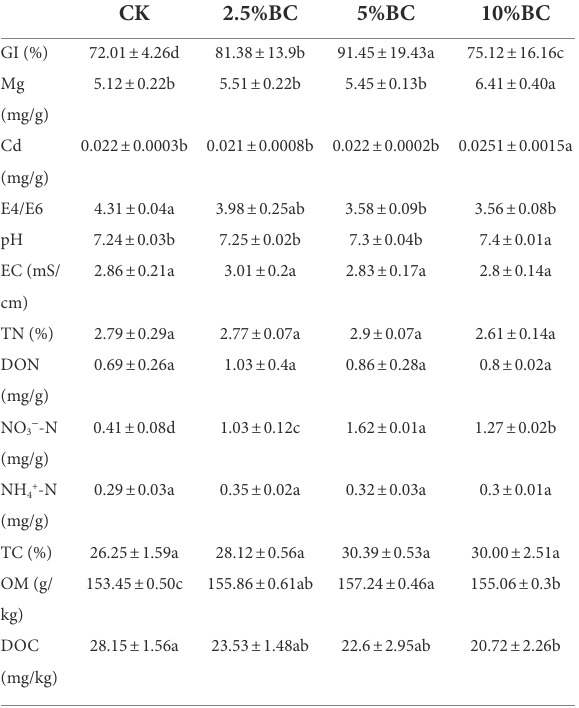
TABLE 1 Effect of biochar addition on physicochemical properties of the final composting